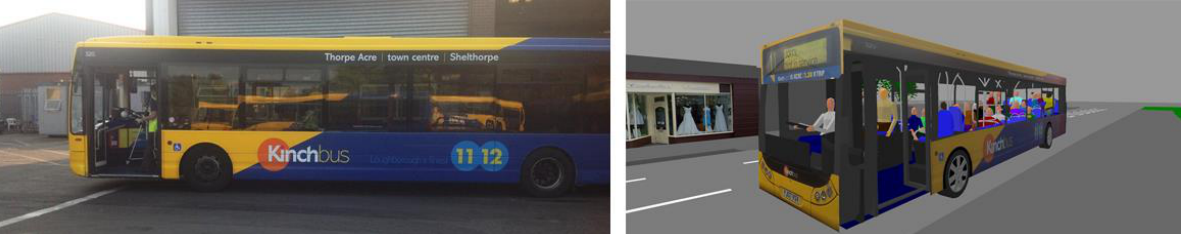
Figure 4. Bus used for the modelling activity, a 42 seat Kinchbus No 12 (left) and the resulting model in SAMMIE